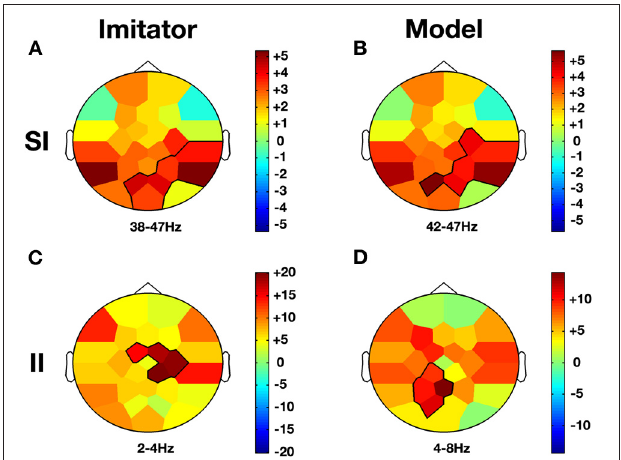
FIGURE 5 | Co-ownership and low/high frequency bands effects. Compared to baseline (NVM), Imitator and Model show a similar increase in gamma activity (38–47Hz) in parietal regions during SI while this effect was not present in II ( A and B ). However, there is an increase for both delta/theta activity (2 – 8Hz) in II but topographies are different. While this change occurs in the right central region for the Imitator (C) , it is more localized over the precuneus region for the Model (D) . The color stands for the mean t -values across the frequency range of the considered clusters. Statistical clusters are outlined in thick black lines for both representations. For abbreviations, see previous figures. SI, spontaneous